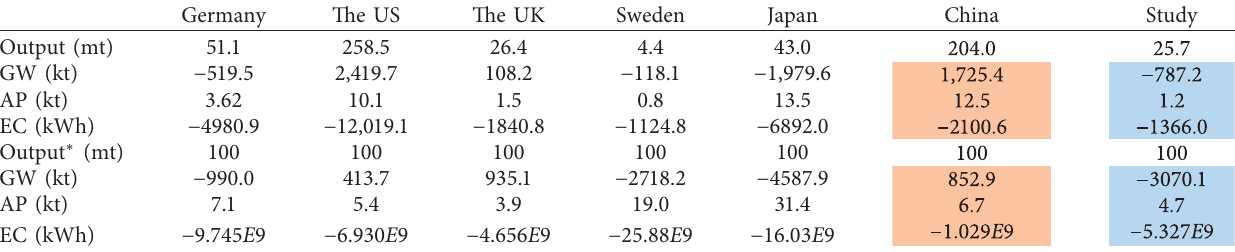
Figure 4: Contributions to landfill, incineration, and composting processes (units: GW-kg/t MSW; AP-kg/t MSW; EC-kWh/t MSW). Table 6: Emissions and capacities of waste classification methods in each